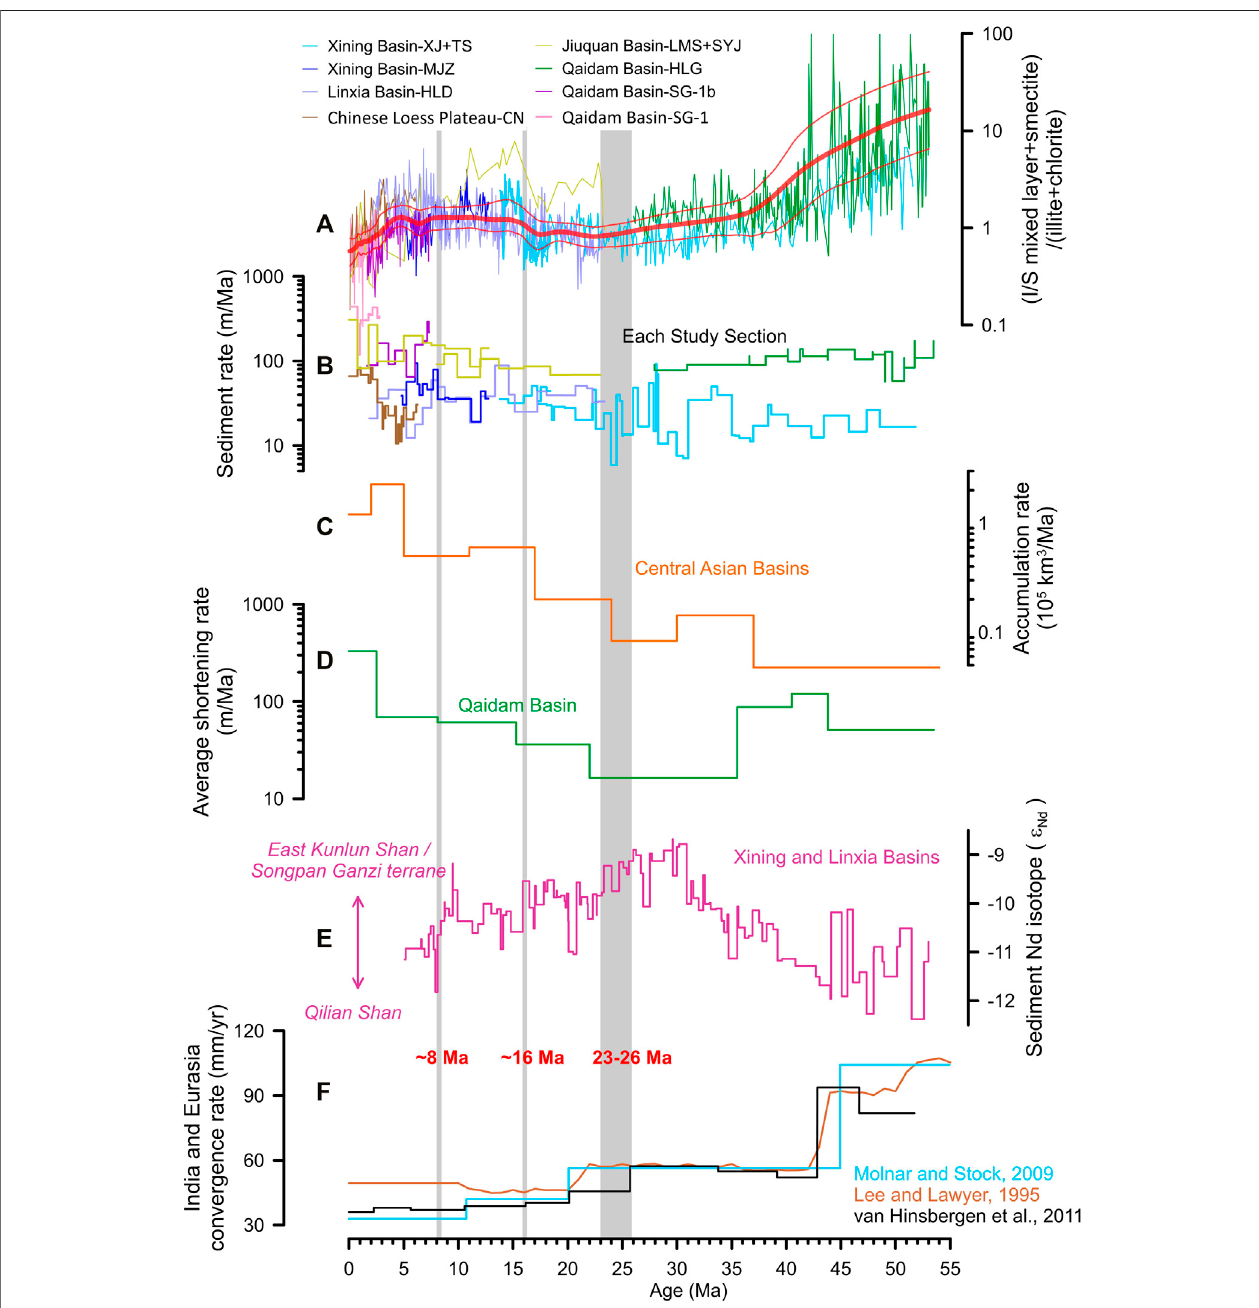
FIGURE 2 | Cenozoic silicate weathering history in the NE Tibetan Plateau and its comparison with proveannce, erosion and tectonic records (A) Compiled (I/S mixed layer + smectite)/(illite + chlorite) ratio (B) Sedimentation rates of the study sections (Xining Basin: XJ section, Dai et al., 2006; TS core, Zan et al., 2015; MJZ section,Yangetal.,2017;QaidamBasin:SG-1core,Zhangetal.,2012;SG-1bcore,Zhangetal.,2014;HLGsection,Fangetal.,2019b;LinxiaBasin:HLDsectionand HZ core, Fang et al., 2016; Jiuquan Basin: LJM section, Fang et al., 2005; SYJ section, Song, 2006; Chinese Loess Plateau: CN section, Song et al., 2001) (C) Average accumulation rate in Central Asian basins (Métivier et al., 1999) (D) Average shortening rate in the Qaidam Basin (Bao et al., 2017) (E) Nd isotope of decarbonated bulk sediments from the Xining and Linxia Basins (He et al., 2019; Yang et al., 2021a) (F) Convergence ratesbetween India and Eurasia (Lee and Lawver, 1995; Molnar and Stock, 2009; van Hinsbergen et al., 2011).